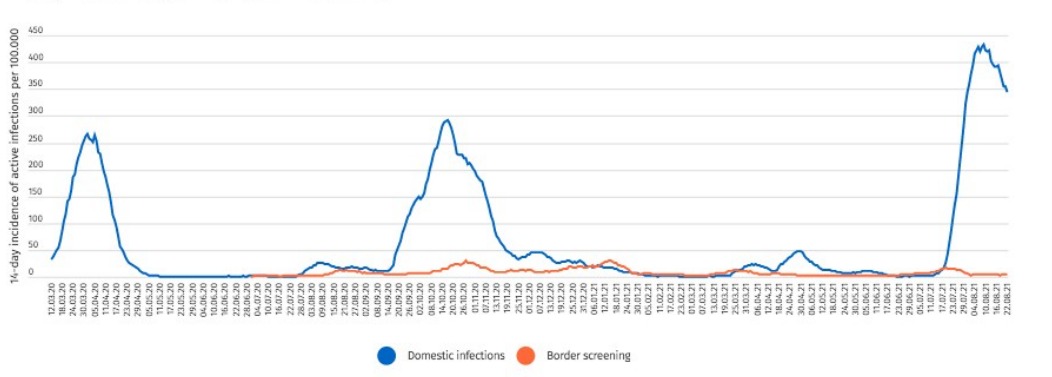
Figure 1. Fourteen-day incidence rate per 100,000 inhabitants in Iceland